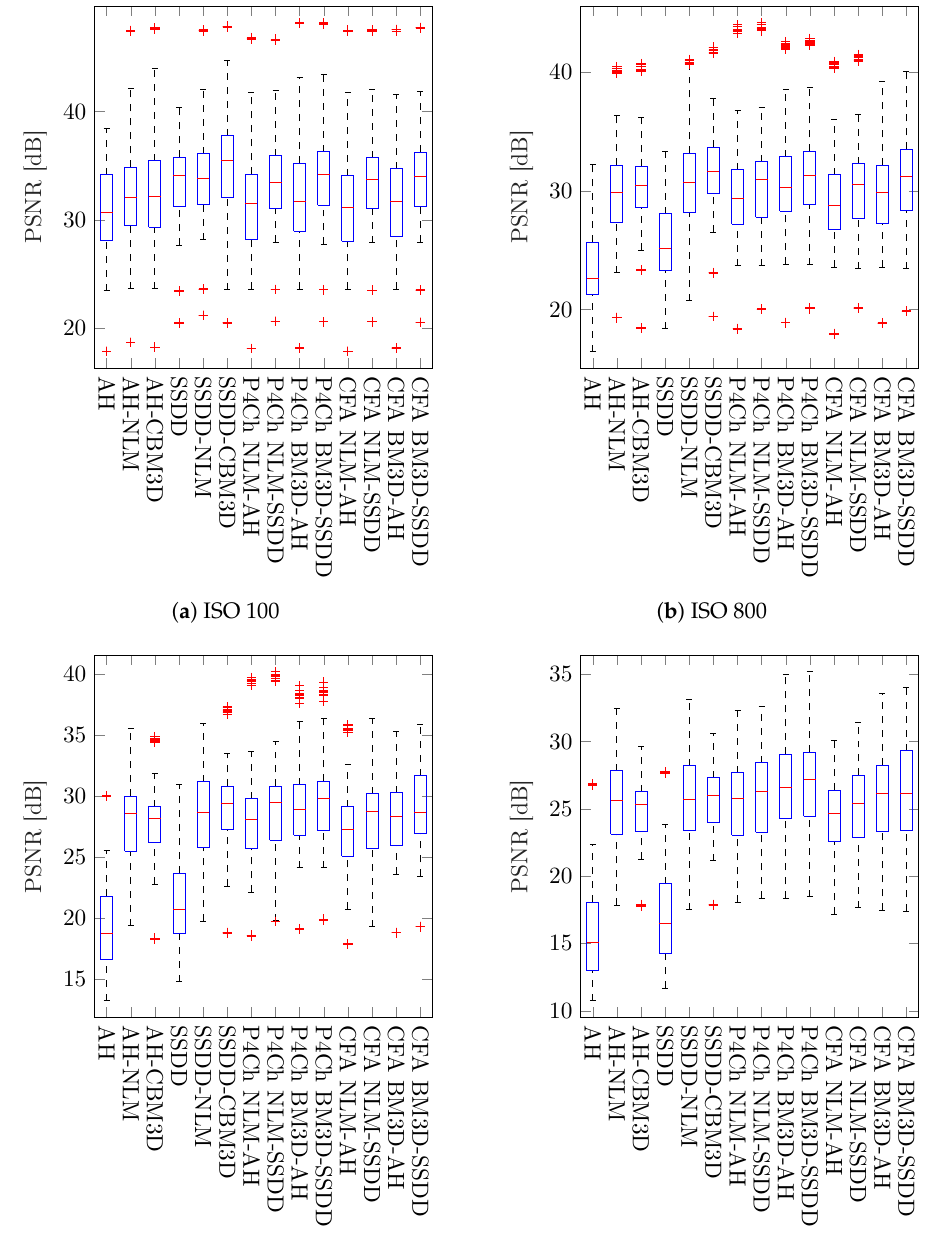
Figure 13. Box plots of PSNR values for all images depending on the noise